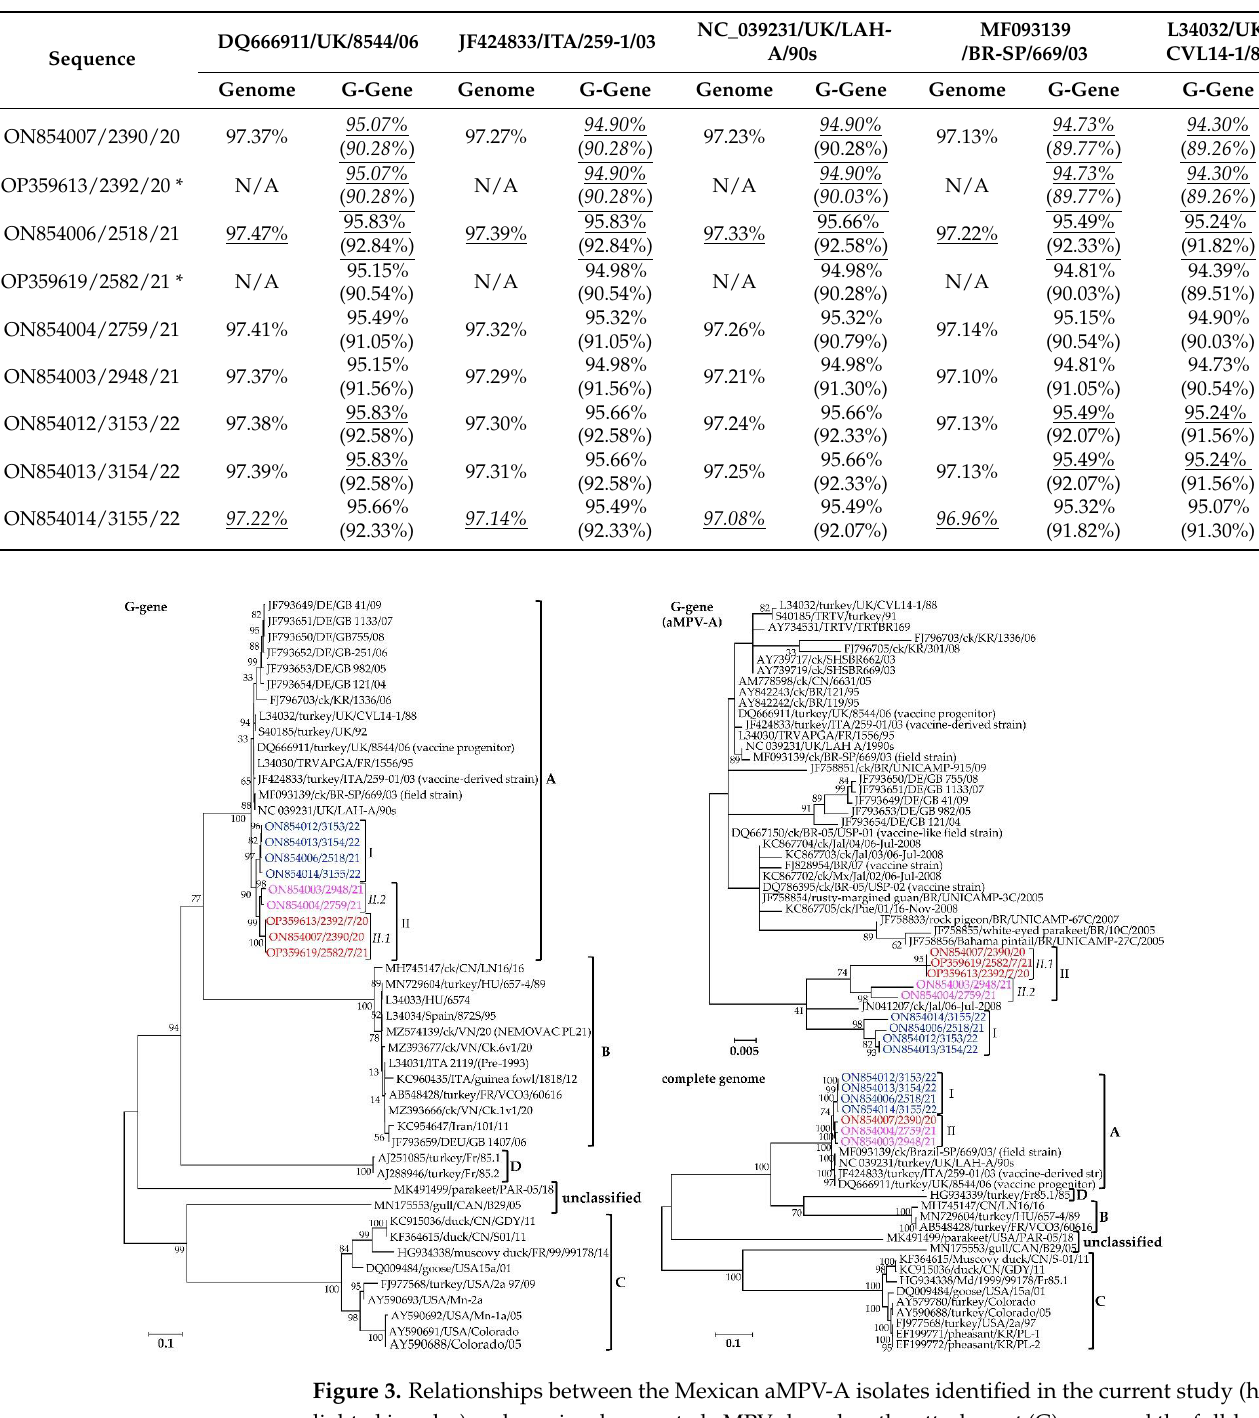
Table 2. Comparison of nt and deduced aa (in brackets) identities between the full genome and G-gene sequences of the aMPVs identified in this study and their closest BLASTn matches. The highest and lowest identities are underlined (in bold and italicized fonts, respectively). Note: only the G-gene sequence of strain CVL14-1/88 is available in GenBank; the Mexican isolates 2392/20 and 2582/21 (marked with asterisk “*”) did not have full-length genome sequences. GenBank accession numbers are indicated in the isolate names.